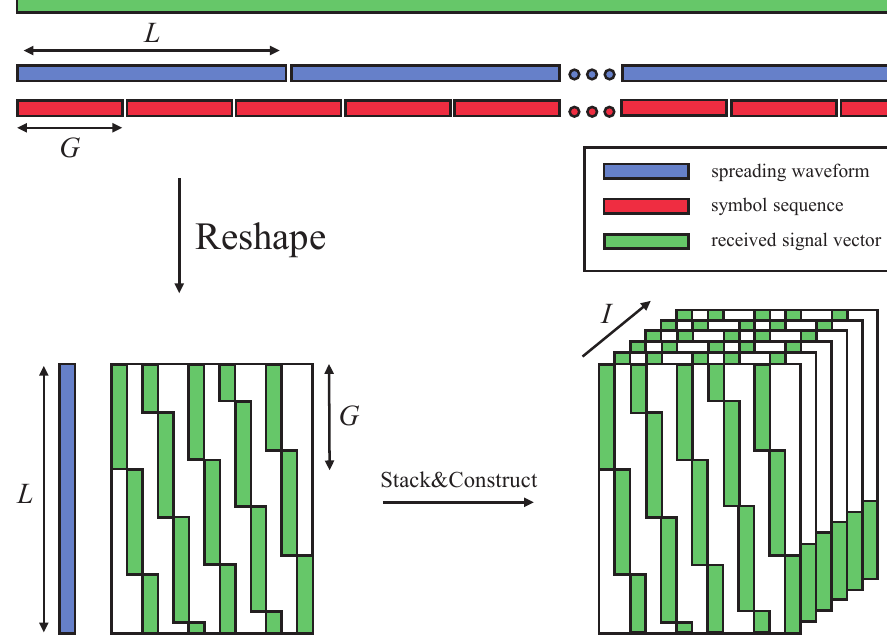
Figure 2. Illustration of the missing tensor model for long-code multiuser DSSS